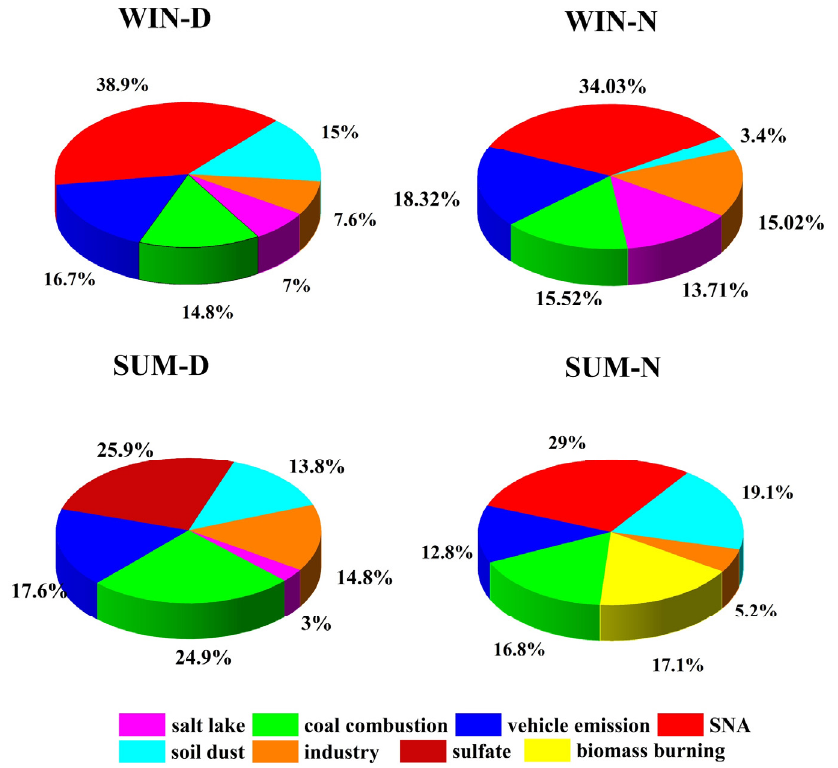
Figure 8. Source contribution percentages of PM2.5 in Lanzhou (WIN-D: winter-day, WIN-N: winter-night, SUM-D: summer-day, SUM-N: summer-night).